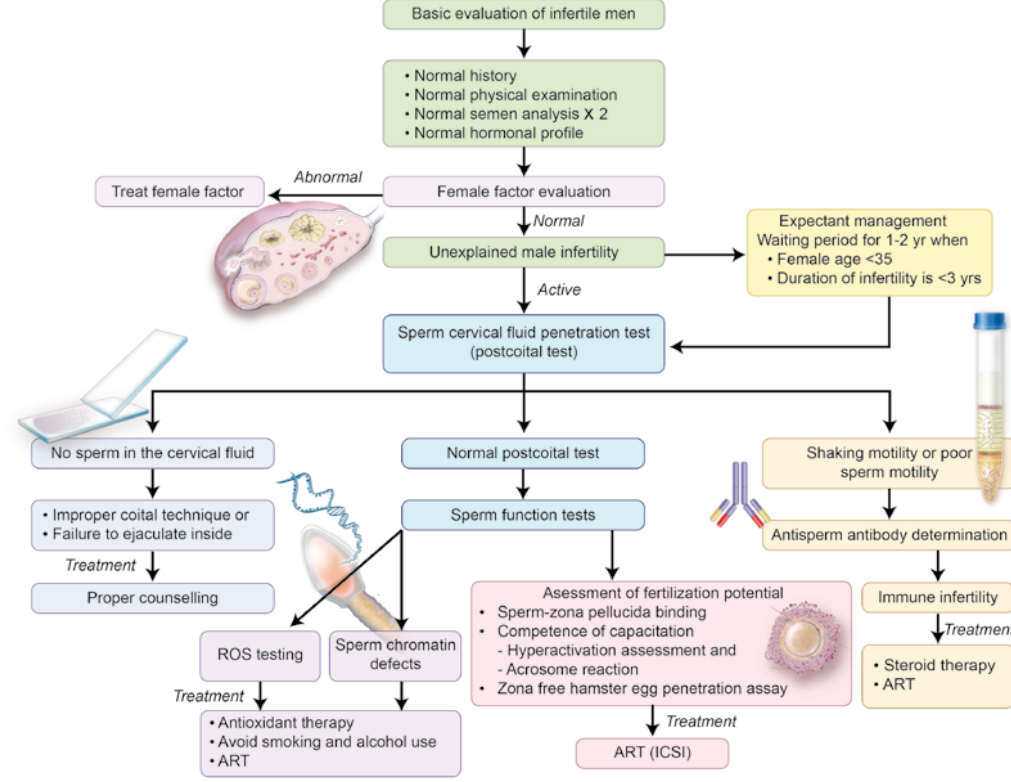
Figure 1 - A proposed algorithm for the clinical management of men with unexplained male